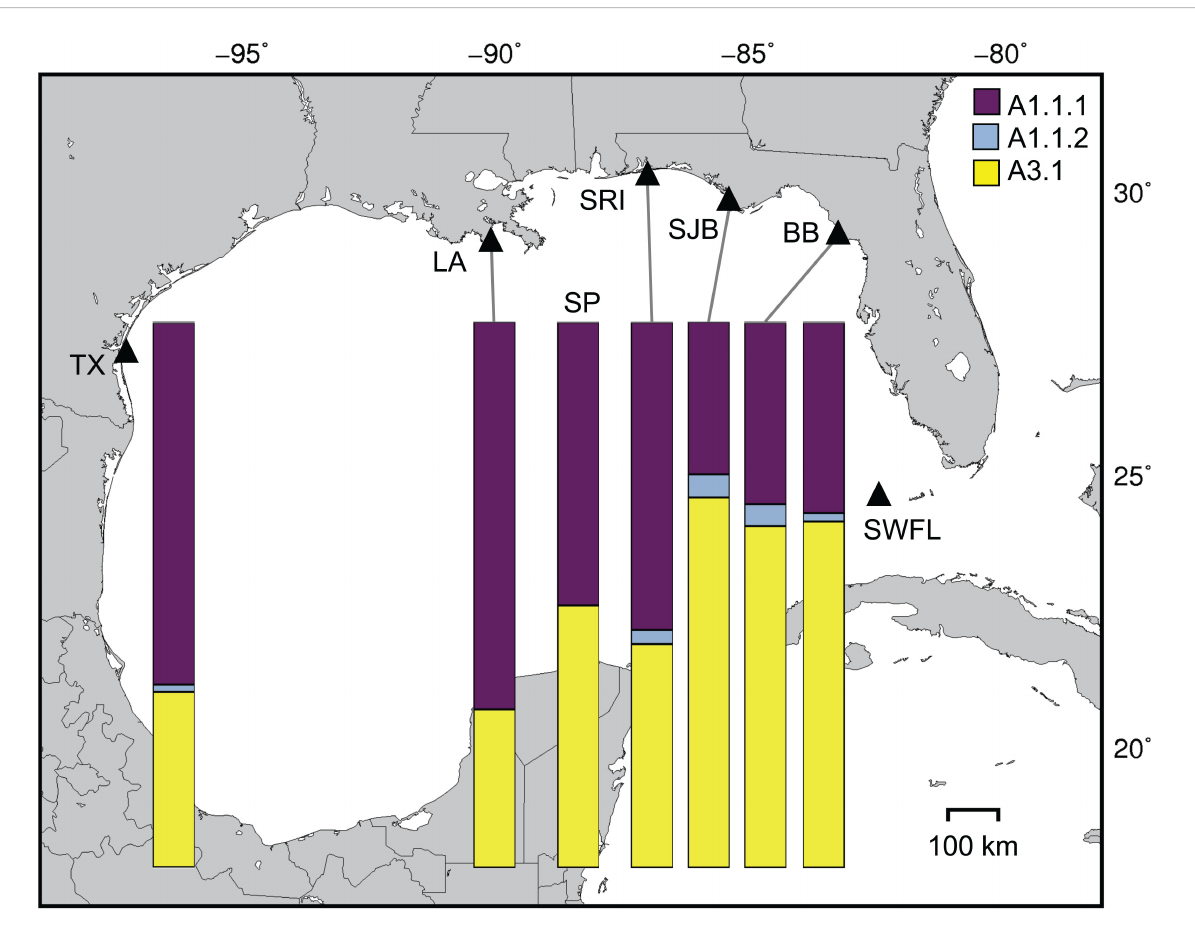
FIGURE 2 Relative frequencies of the two most common mitochondrial haplotypes, CM-A1.1 and CM-A3.1, in juvenile green turtle foraging aggregations in the northern Gulf of Mexico. CM-A1.1 is subdivided into conserved (Tamaulipas) CM-A1.1.1 and derived (Florida) CM-A1.1.2. Site codes are explained in Figure